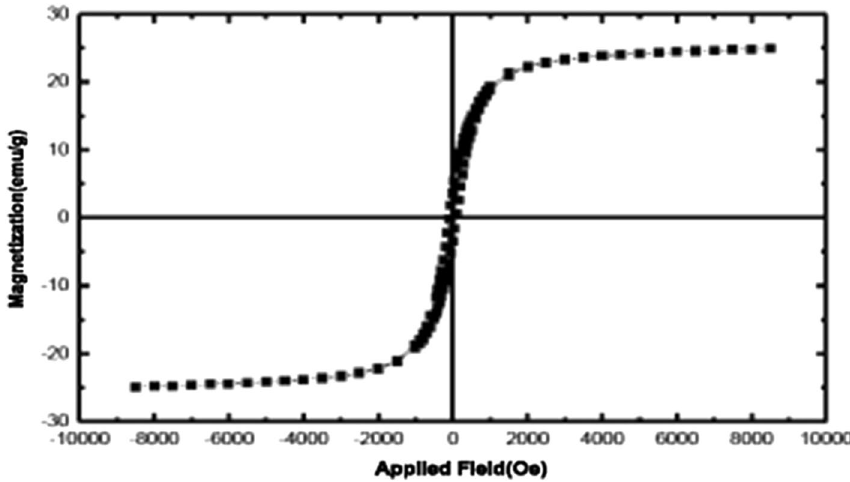
Fig. 2 Magnetization curve of the Ni 0.5 Zn 0.5 Fe 2 O 4 /Ag magnetic nanoparticles at room